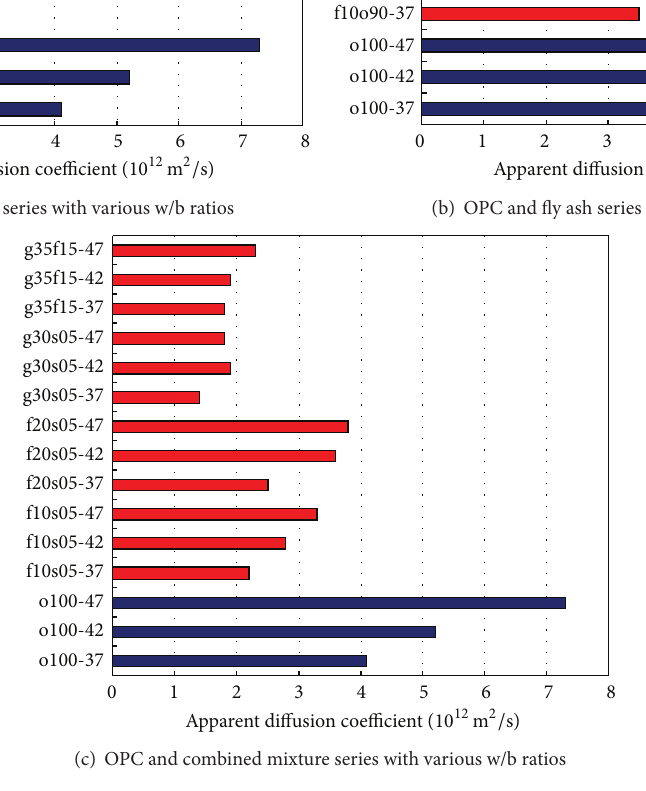
Figure 4: Comparison of measured diffusion coefficient with OPC concrete.